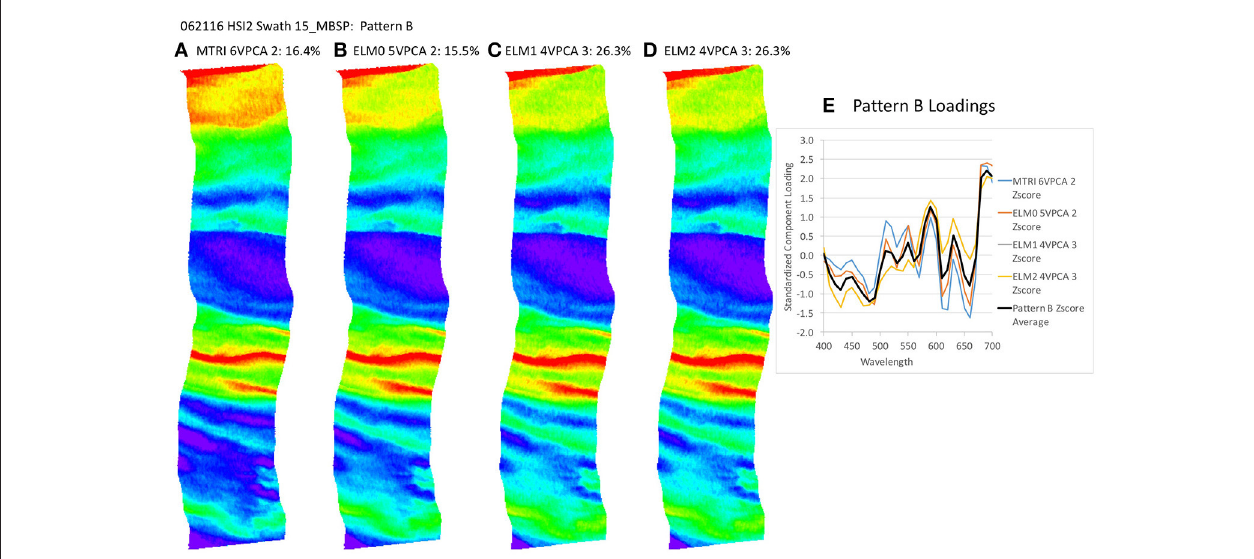
FIGURE 9 | Spatial distribution of varimax-rotated principal component analysis (VPCA) component pattern B. (A) Michigan Tech Research Institute (MTRI) correction method decomposition. (B) Empirical Line Method 0 (ELM0) correction method decomposition. (C) Empirical Line Method 1 (ELM1) correction method